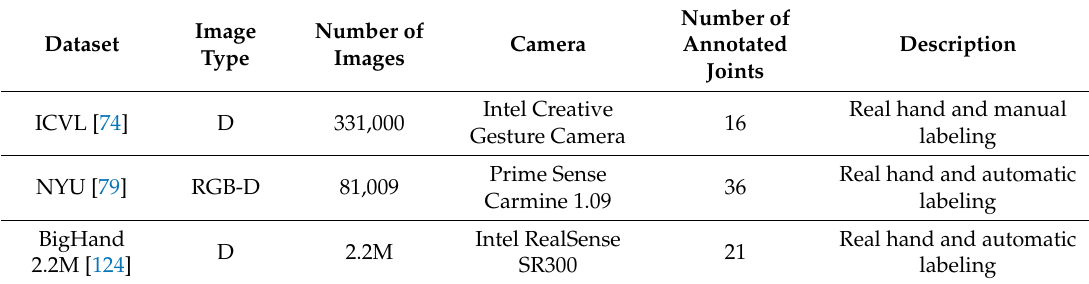
Table 6. Commonly used public datasets for vision-based hand pose